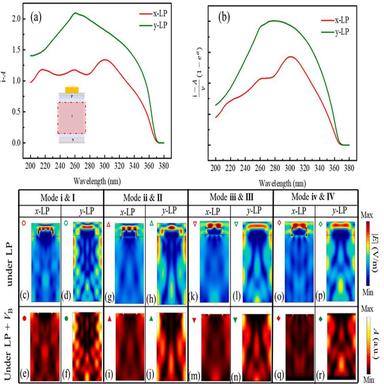
(a) integrated absorption (i-A) in intrinsic region of MGPIN structure, (b) the plot of i-A (1-eα ) /ν vs wavelength of MGPIN, near electric field distribution of each LD mode under (c, j, k, o) x-LP and (d, h, l, p) y-LP, and absorption distribution of each η mode under (e, I, m, q) x-LP and (f, j, n, r) y-LP.